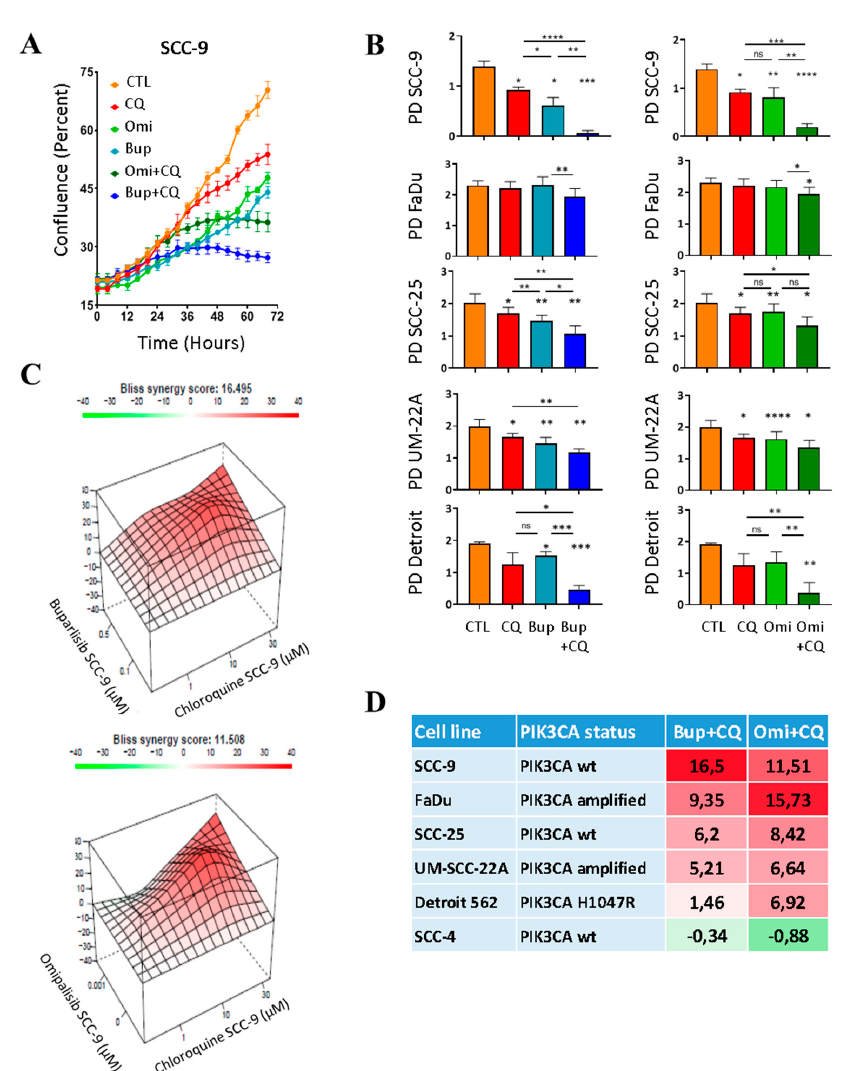
Figure 2. PI3Ki and chloroquine (CQ) work in synergy to decrease proliferation of HNSCC cell lines. ( A ) Real-time cell proliferation of SCC-9 captured by IncuCyte S3 (Essen Bioscience, Ann Arbor, MI, USA) for 3 days with vehicle (CTL), 0.5 µ M Bup or 1 nM Omi and ± 10 µ M CQ. Data are the mean of triplicates ± SEM. and are representative of four independent experiments. ( B ) Evaluation of population doubling after 3 days in culture for five HNSCC cell lines with / without PI3Ki and CQ at 0.5 µ M Bup, 1 nM Omi and 10 µ M CQ (except for Detroit 562: 1 µ M Bup, 10 nM Omi, and 30 µ M CQ). Data are the mean ± SD; n = 4 independent experiments in triplicates for SCC-9, UM22A, and Detroit 562, and n = 5 in triplicates for FaDu and SCC-25. Data were analyzed with ANOVA test, * p < 0.05, ** p < 0.01, *** p < 0.001, and **** p < 0.0001. * p without underscore bar represents significant difference compared with CTL (vehicle). ( C ) Three-dimensional (3D) diagrams representing Bliss score (z) versus PI3Ki concentration (y) and autophagy inhibitor concentration (x). SCC-9 cell line was incubated with different concentrations of the inhibitors alone or in combination (1, 10, 30 µ M CQ; 0.1 or 0.5 µ M Bup; 0.1 or 1 nM Omi). Real-time proliferation was recorded for four days with Top: Bup. Bottom: Omi. ( D ) Bliss synergy scores for treatment combinations and PIK3CA status of six HNSCC cell lines. Bliss synergy scores over 1 indicate synergy. Cell lines were incubated in IncuCyte S3 (Essen Bioscience, Ann Arbor, MI, USA), as described with different concentrations of the inhibitors alone or in combination (1, 10, 30 µ M CQ; 0.1 or 0.5 µ M Bup; 0.1 or 1 nM Omi with the exception of FaDu with 1 or 5 nM Omi, and of Detroit 562 with 0.2 or 1 µ M Bup and 2 or 10 nM Omi). Real-time proliferation was recorded for 3-4 days with IncuCyte S3 (Essen Bioscience, Ann Arbor, MI,